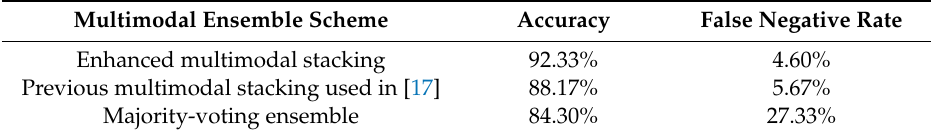
Table 3. Detection performance comparison of multimodal ensemble schemes.